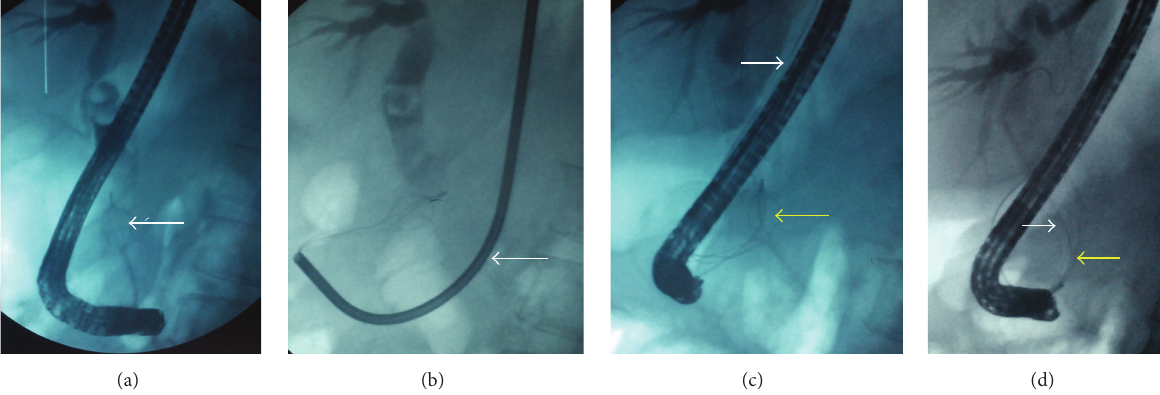
Figure 1: (a) The entrapped stone of almost 20 mm diameter and the impacted basket (arrow). (b) The metal sheath of extraendoscopic lithotriptor advanced to crush the stone (arrow). (c) The fracturing central traction wire (white arrow) and the basket without stone breakage (yellow arrow). (d) The basket/stone complex (white arrow) caught in the rescue standard basket (yellow